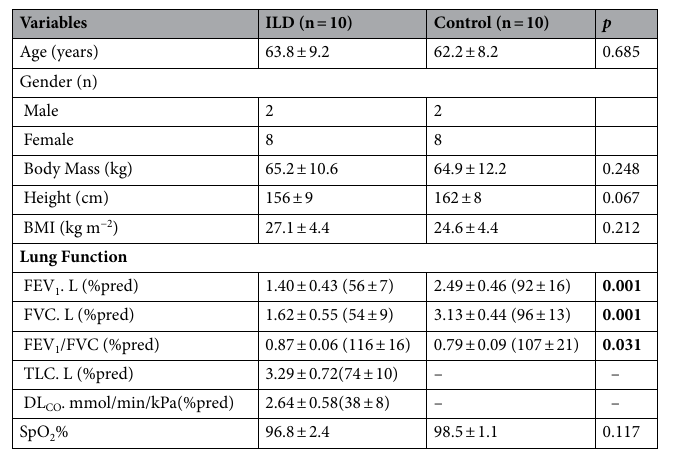
Table 1. Participants’ characteristics (Mean ± SD). n: number of participants; SD: standard deviation; BMI: body mass index; FVC: forced vital capacity; FEV 1 : forced expiratory volume in one second; TLC = total lung